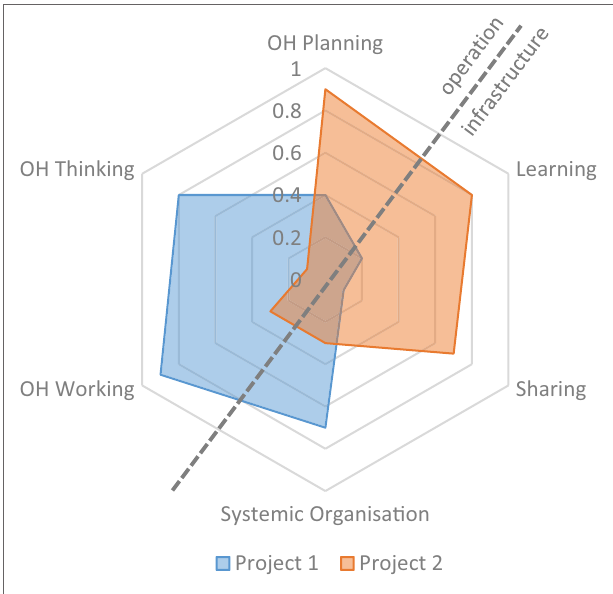
FIgURe 4 | Example of the One Health (OH)-ness spider diagram for two fictive OH